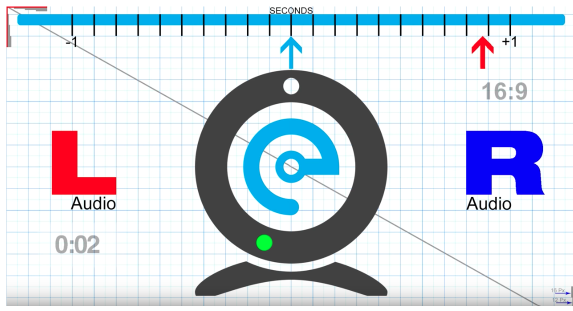
Figure 5. IoT IP Camera Video Feed (scenario one and two).